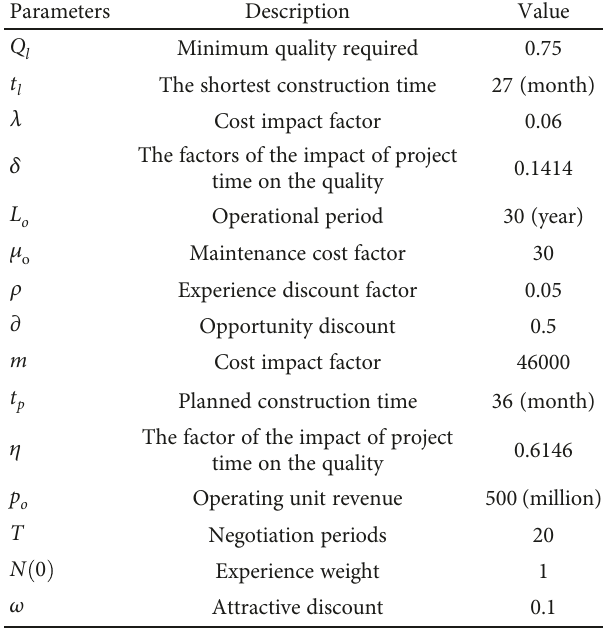
Table 2: Initializations of the experimental